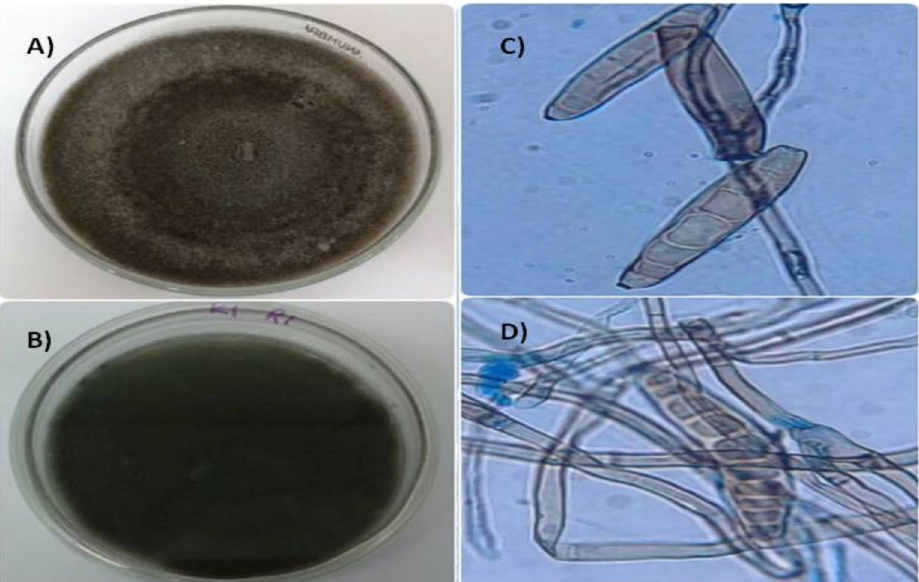
Figure 2. Morphological view of rice brown spot fungal pathogens: Exserohilum rostratum and Bipolaris oryzae axenic cultures and under light microscope 100× magnification. ( A ) 14-day-old E. rostratum ; ( B ) 14-day-old B. oryzae ; ( C ) B. oryzae conidia in light colour displaying minute curve and almost cylindrical shape; ( D ) E. rostratum conidia displaying darkened cylinder and protruding